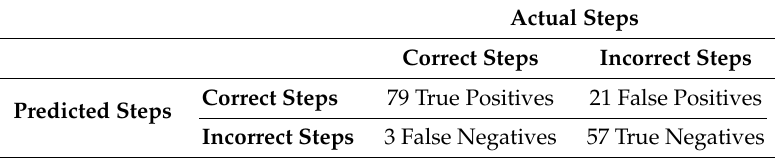
Table 1. Confusion Matrix for the step recognition of the Forth and Back